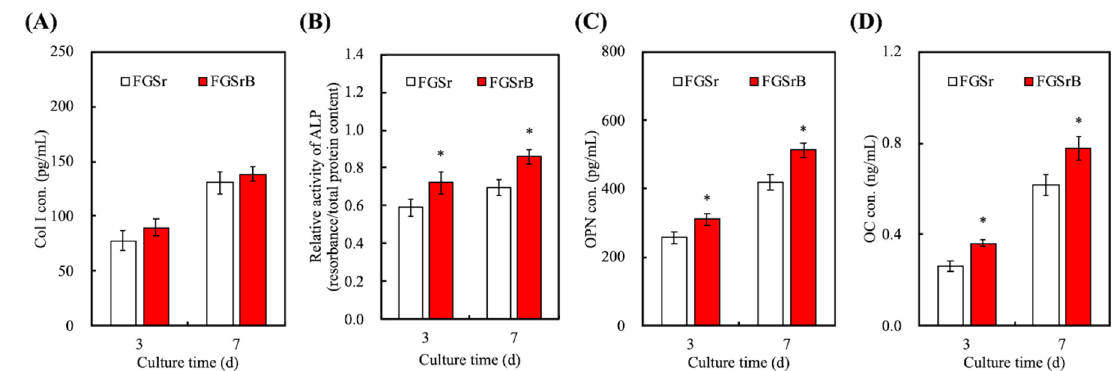
Figure 7. (A) Col I, (B) ALP, (C) OPN and (D) OC profiles of the WJMSC-laden FGSr and FGSrB Figure 7. ( A ) Col I, ( B ) ALP, ( C ) OPN and ( D ) OC profiles of the WJMSC-laden FGSr and FGSrB scaffolds in osteogenic differentiation medium. “*” indicates a significant difference ( p < 0.05) when sca ff olds in osteogenic di ff erentiation medium. “*” indicates a significant di ff erence ( p < 0.05) when compared to FGSr. Data presented as mean ± SEM, n = 5 for each group. compared to FGSr. Data presented as mean ± SEM, n = 5 for each